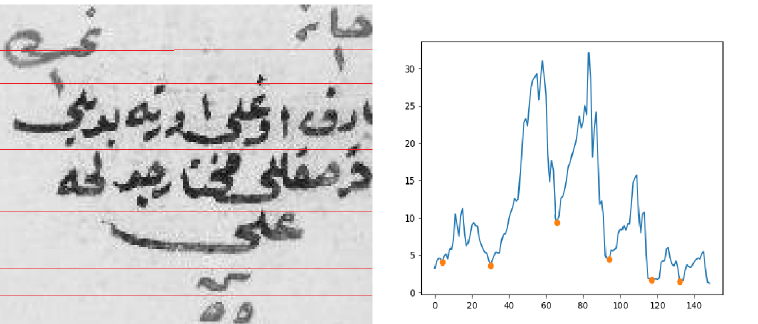
Figure 3. A sample segmented individual in the left and corresponding valleys in HPP in the right are shown.